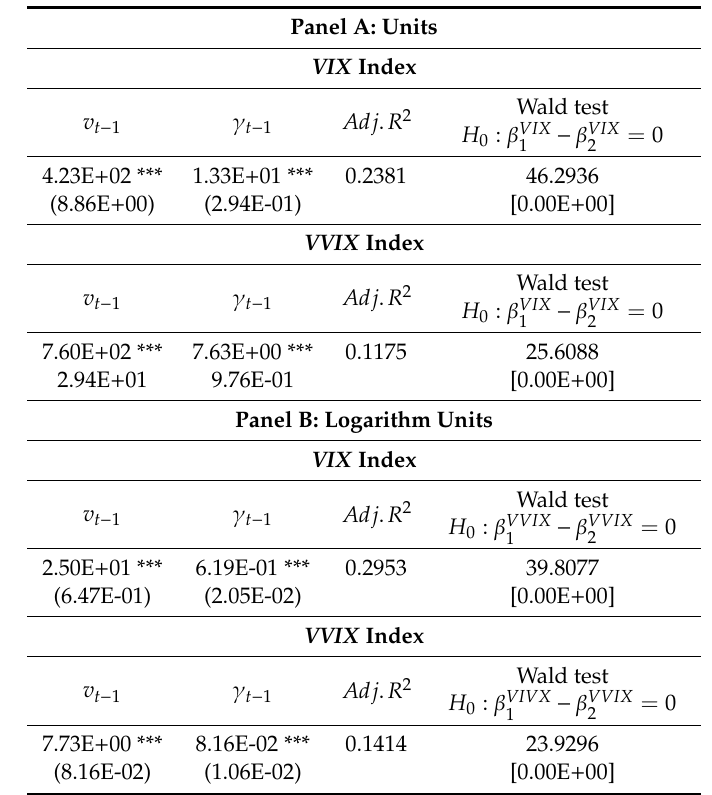
Table 4. Estimation results for the stochastic volatility of